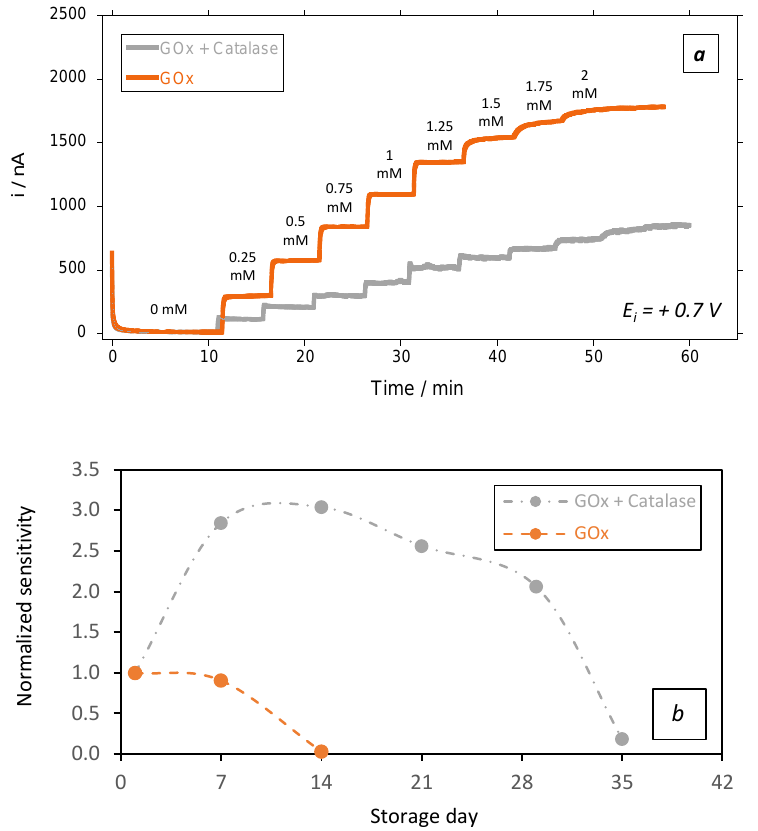
Figure 7. ( a ) Amperometric responses at + 0.7 V vs. Ag/AgCl in PBS(1X) medium under hydrodynamic conditions of 200 rpm for testing of biosensors at day 1 in presence of an increased concentration of glucose, and ( b ) stability in function of time of the chitosan-based biosensing membranes deposed on gold screen-printed electrodes and stored in PBS + glucose (2 mM) at 37 ◦ C: orange plots: GOx, and grey plots: GOx + added catalase (average value and standard deviation on 2 sensors).